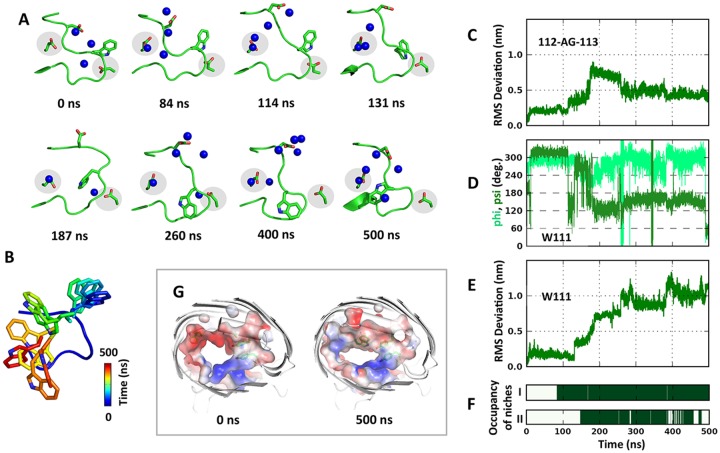
Gating process in Omp-Pst2 monomer B at negative voltage.(A) Snapshots of L3 tip. In each snapshot, residues W104 to D117 are shown in cartoon; W111, D114, E258 and D312 in sticks; and K+ within 3.5 Å of the L3 tip in blue spheres. The acidic niche I (E258) and niche II (D312) are highlighted in gray. (B) W111 movements in every 50 ns. The RMSD of 112-AG-113 (C), the phi/psi angle of W111 (D) and the RMSD of W111 (E) are laid out to demonstrate the sequential events leading to niches exposure and subsequent binding of cations within them (F). G) The electrostatic potential surface at 0 ns and 500 ns. The extent of color scale is ± 100 kT/e. Y95, Y99, A103 and W111 are shown in sticks.